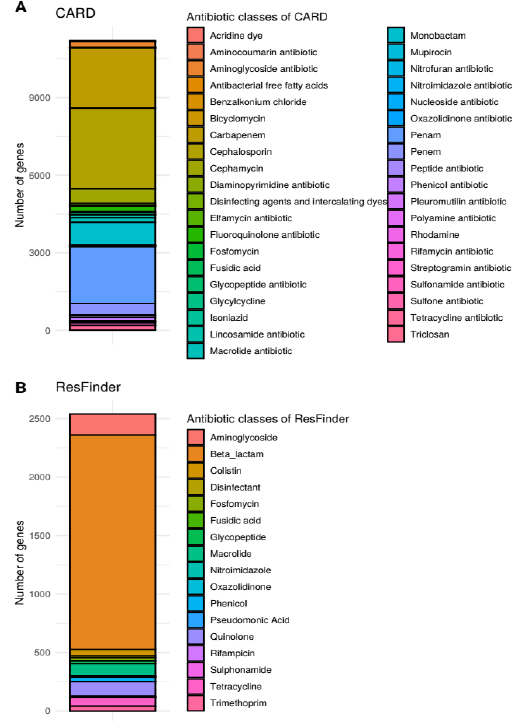
Figure 2. Number of unique genes for each antibiotic class stored in CARD and ResFinder. Bars represent the number of genes in each unique antibiotic or biocide categories, where colors are associated with the specific antibiotics themselves. As one gene can confer resistance to multiple antibiotics, it is possible that the same gene is counted for two or more antibiotics. The plots show the data for CARD ( A ) and ResFinder ( B ), respectively.